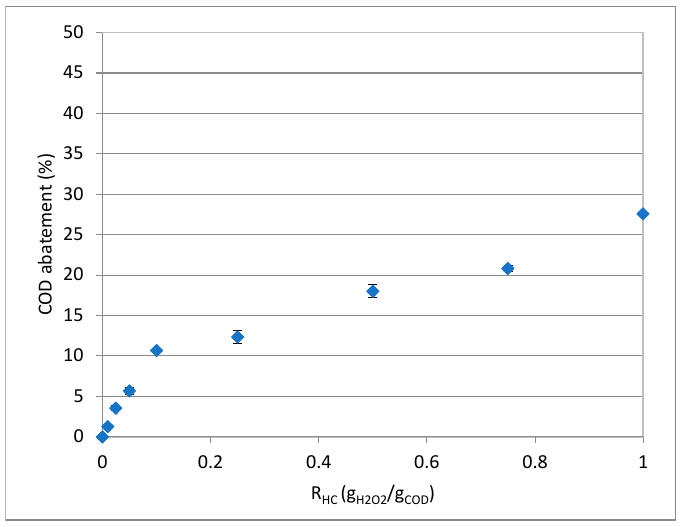
Figure 1. COD abatements detected in the AHP tests conducted with different H 2 O 2 dosages.